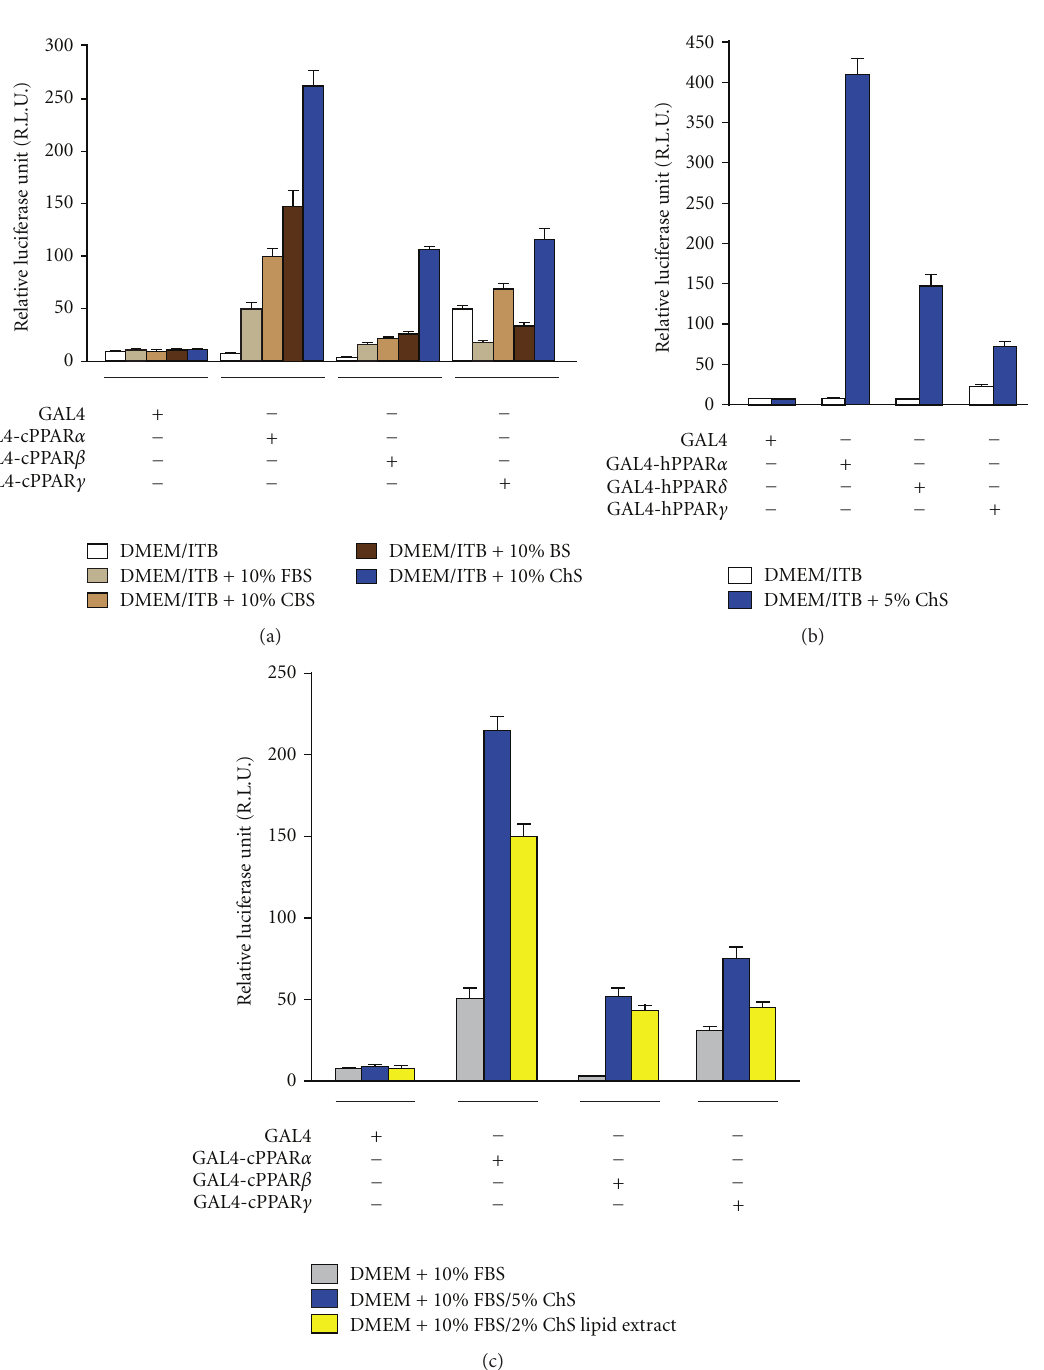
F 3: Effect of serum on the transactivation function of cPPARs. (a), (b). Effects of serum on the transactivation function of PPARs. Serum-induced transactivation function of cPPARs (a) or hPPARs. (b) Aer transfection with each plasmid mixture, cells were cultured